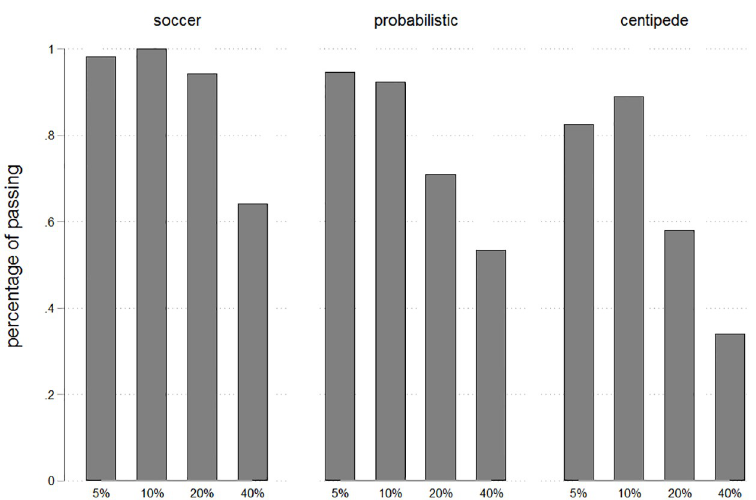
Fig 6. Mean expected percentages of passing by treatment. Percentages denote the share of participants who are expected to pass among all those who will reach the respective stage. As can be seen, percentages are comparable to those in Fig